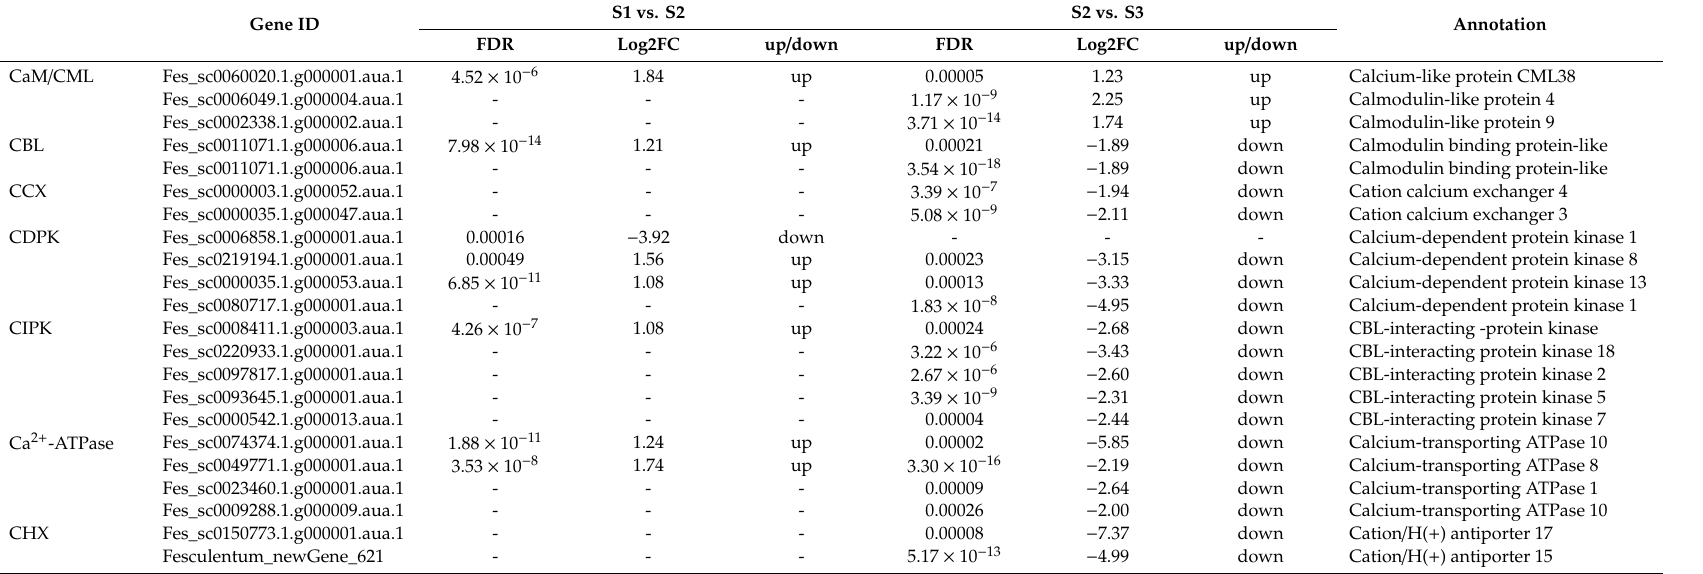
Table 2. DEGs involved in Ca 2 + signaling pathways. S1, S2, and S3 stand for the seed samples at pre-filling stage, filling stage, and initial maturity stage, respectively. FDR stands for false discovery rate. Log2FC stand for Log2 fold